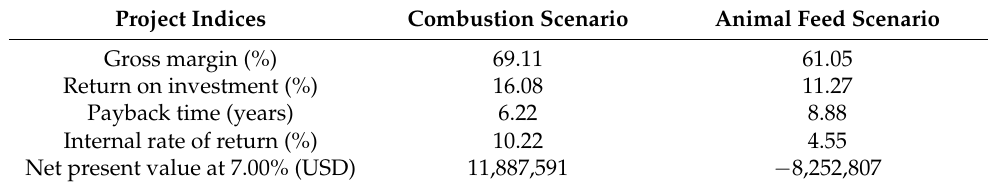
Table 4. Different model scenarios for process